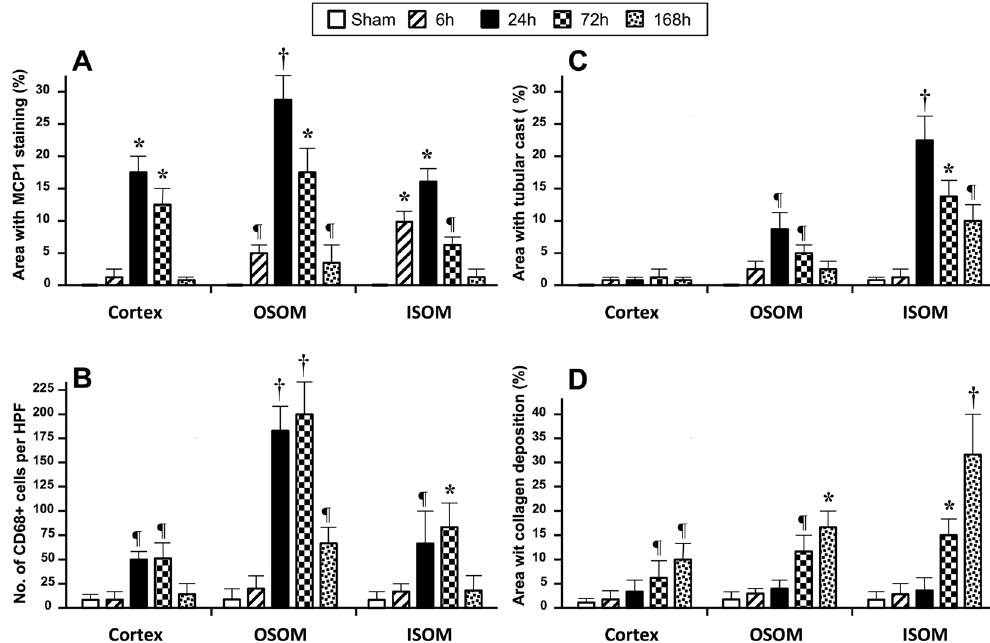
Figure 3. Bar chart illustrations of changes in MCP-1, CD68 + cells, tubular cast formation, and collagen deposition (sirius red) in immunohistochemical studies at different time points among the cortex, OSOM, and ISOM as compared with the sham control (¶ indicates P < 0.05, * indicates P < 0.01, and † indicates P < 0.001). ( A ) Percentage changes in areas with positive MCP-1 staining. OSOM and ISOM showed significantly larger areas with MCP-1 staining at 6 hours. All three zones at days 1 and 3 and OSOM at day 7 showed significant increment in areas with MCP-1 staining increases, with peak level at day 1. ( B ) Changes in number of CD68 + cells. All three zones had significant increases in the number of CD68 + cells at days 1 and 3, and OSOM at day 7 with peak level at day 3, especially prominent in OSOM. ( C ) Percentage changes in areas with tubular cast formation. The renal cortex showed no significant differences at all time points. OSOM and ISOM showed significantly more tubular casts at days 1 and 3, and days 1, 3, and 7 respectively with peak level at day 1. ( D ) Percentage changes in collagen deposition. As compared with the sham control, all three zones showed no significant differences in collagen deposition at 6 hours and day 1 after IRI. At days 3 and 7, all three zones harbored significantly more collagen with peak level at day 7, while ISOM was more severely